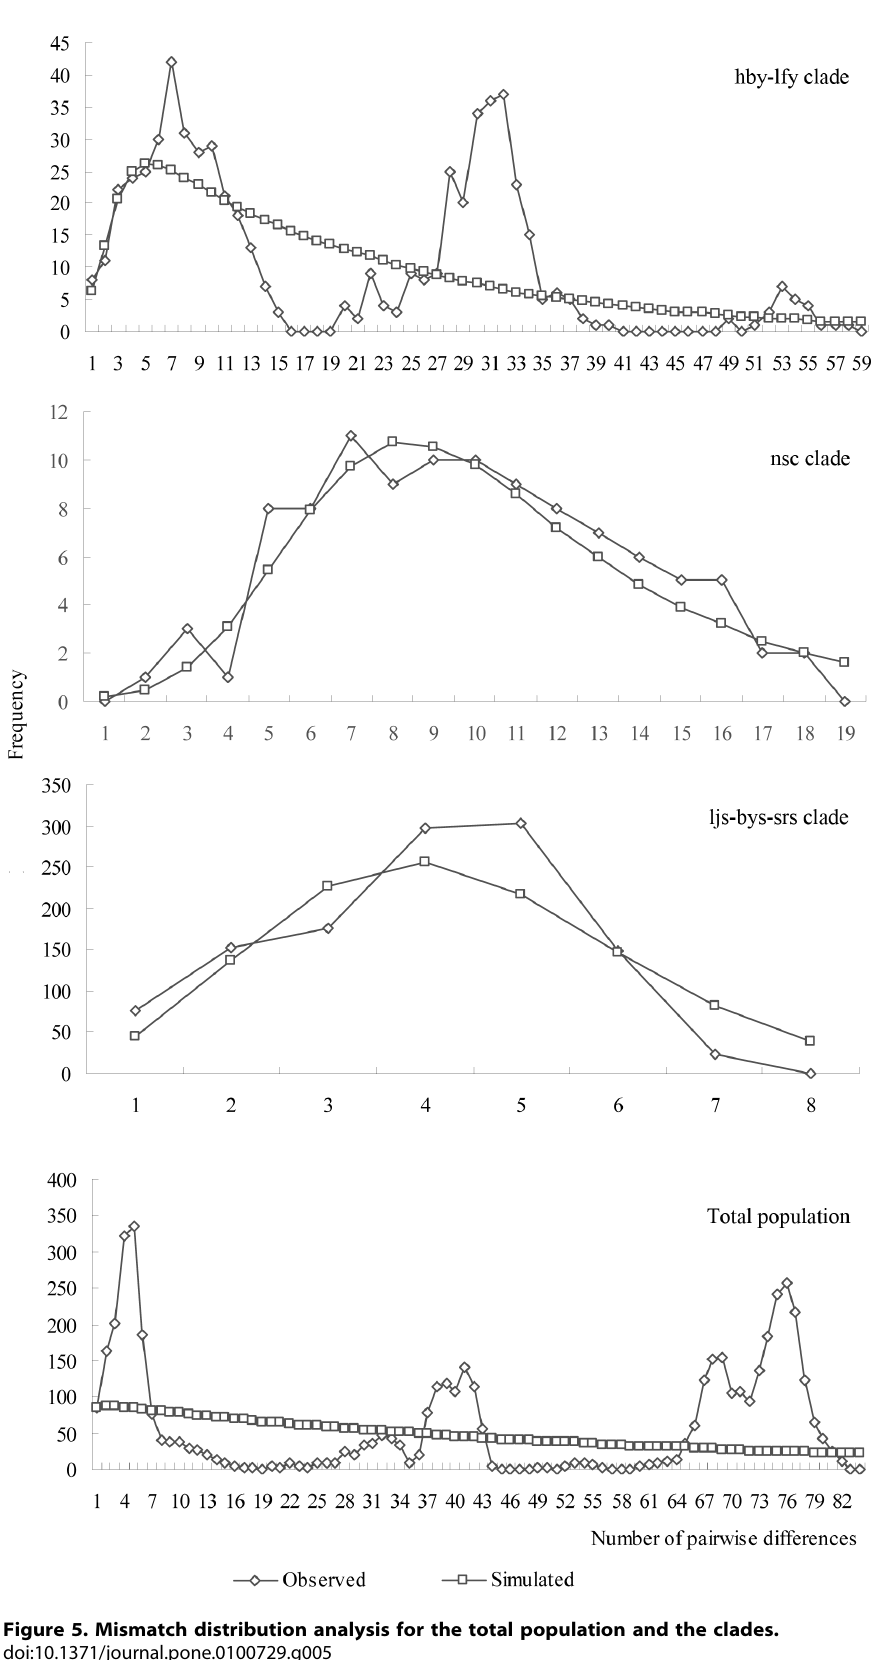
Figure 5. Mismatch distribution analysis for the total population and the clades.